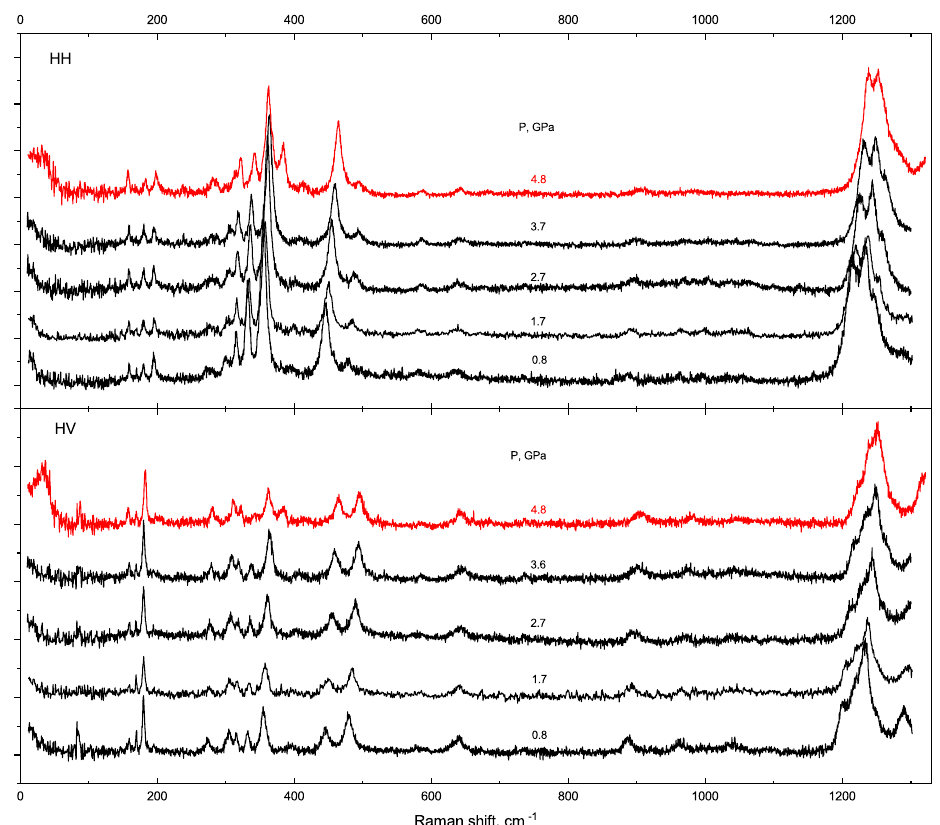
Figure 5. Raman spectra transformation with pressure of TbFe 2.46 Ga 0.54 (BO 3 ) 4 at 296 K. Color code: black— R 32 phase, red— P 3 1 21